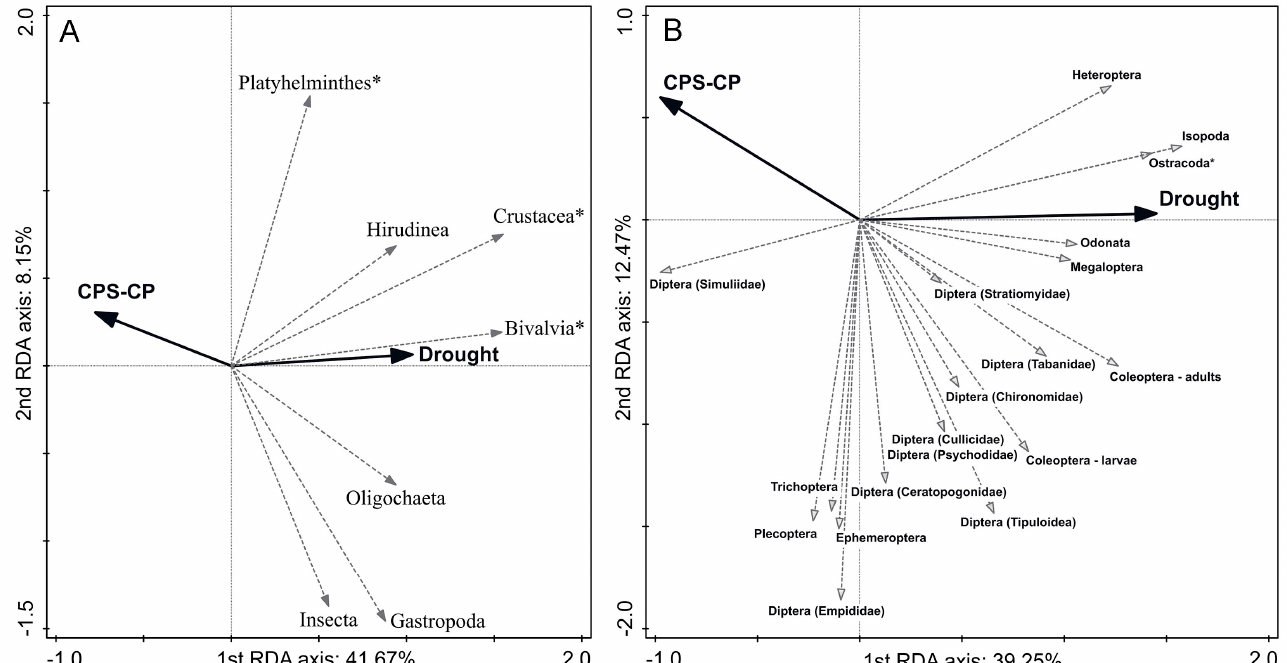
Figure 2. RDA ordination diagrams showing the relationships between disturbances (CPS-CP = chlorpyrifos-cypermethrin contamination derived from the chlorpyrifos sediment contamination, and Drought = drought status; see Materials and Methods) as solid black arrows, with taxa represented by grey arrowed lines. The power of the both disturbances to predict taxonomic compositions was significant (adjusted p < 0.05). The length of arrows corresponds to the quality of fit. ( A ) Relationships between disturbances and the composition of deeper taxonomic levels extrapolated from the abundances of all detected taxa (CPS-CP: explained variation 26.9%, pseudo-F = 3.3; Drought: explained variation 22.9%, pseudo-F = 3.7, respectively; adjusted variation explained by both predictors = 37.28%). Additional information for the labels marked by the asterisks: Platyhelminthes is represented by a single species— Polycelis nigra ; Crustacea is represented by Ostracoda (not determined into a deeper taxonomic level) and Asellus aquaticus ; Bivalvia is represented by only two species— Pisidium casertanum and P. personatum . ( B ) Relationships between disturbances and the composition of deeper taxonomic levels extrapolated from the abundances of arthropods. (CPS-CP: explained variation 24.7%, pseudo-F = 3.0; Drought: explained variation 27.0%, pseudo-F = 4.5, respectively; adjusted variation explained by both predictors = 39.65%). The asterisk marking Ostracoda indicates that this group was not determined into a deeper taxonomic level.